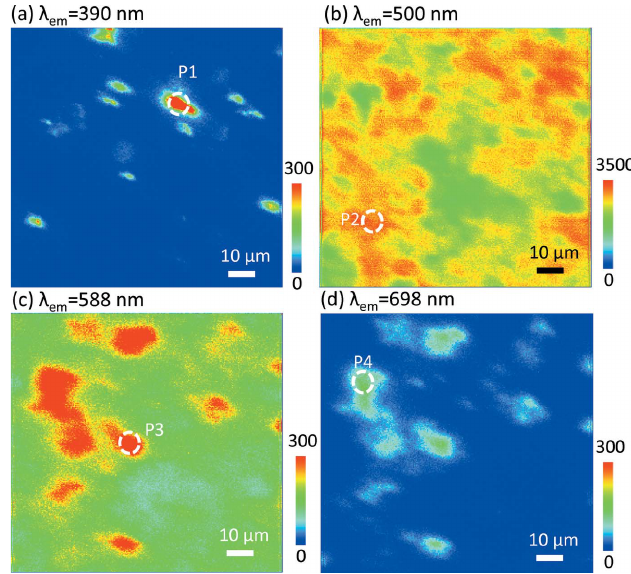
Figure 3 XEOL mapping performed at emission wavelengths ( (cid:2) em ) of approxi- mately ( a ) 390, ( b ) 500, ( c ) 588 and ( d ) 698 nm. The emission distributions of the Eu-doped BaAl 2 O 4 phosphor at different emission wavelengths ( (cid:2) em ) are clearly